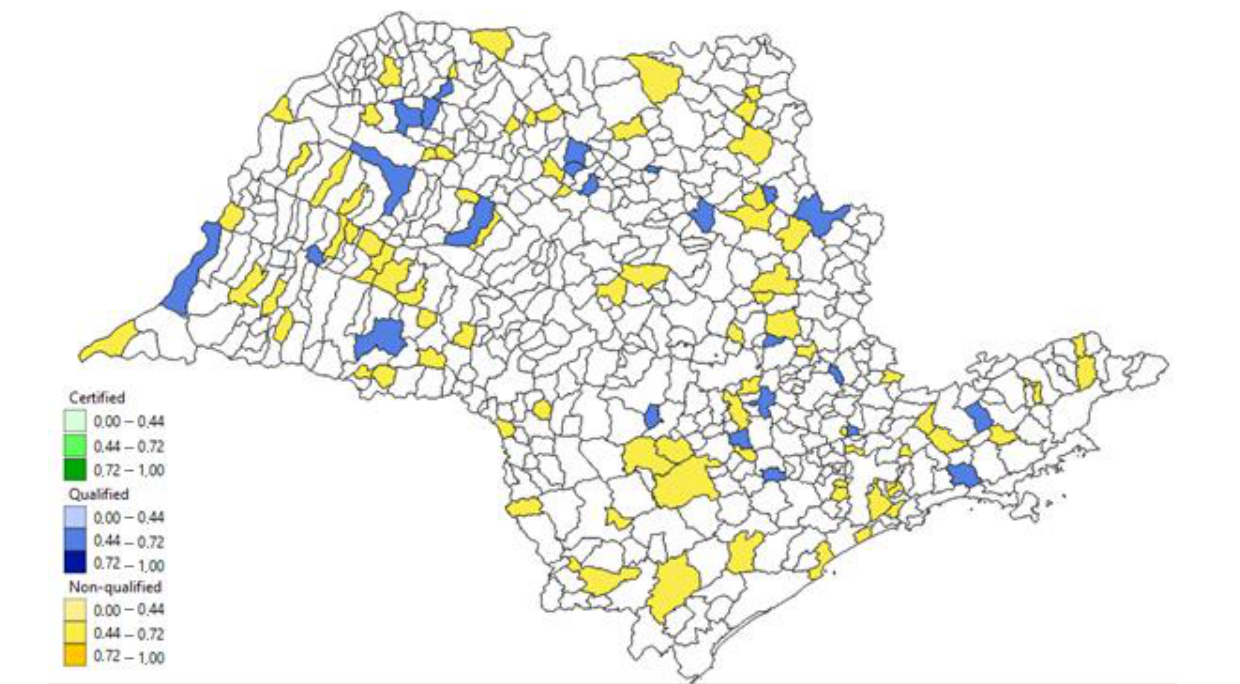
Figure 6. Municipalities in the intermediate range of the Sustainable Human Development Index.